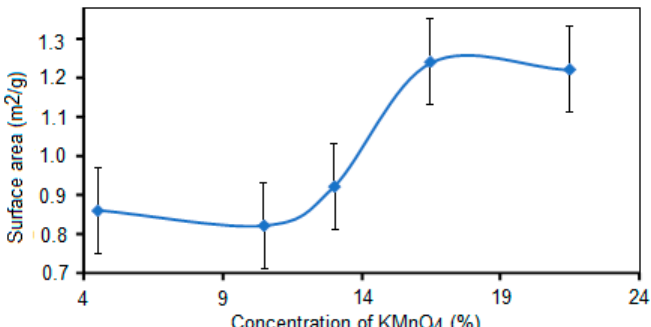
Figure 7. Influence of KMnO 4 concentration in the initial batch on the SHS catalysts surface area.